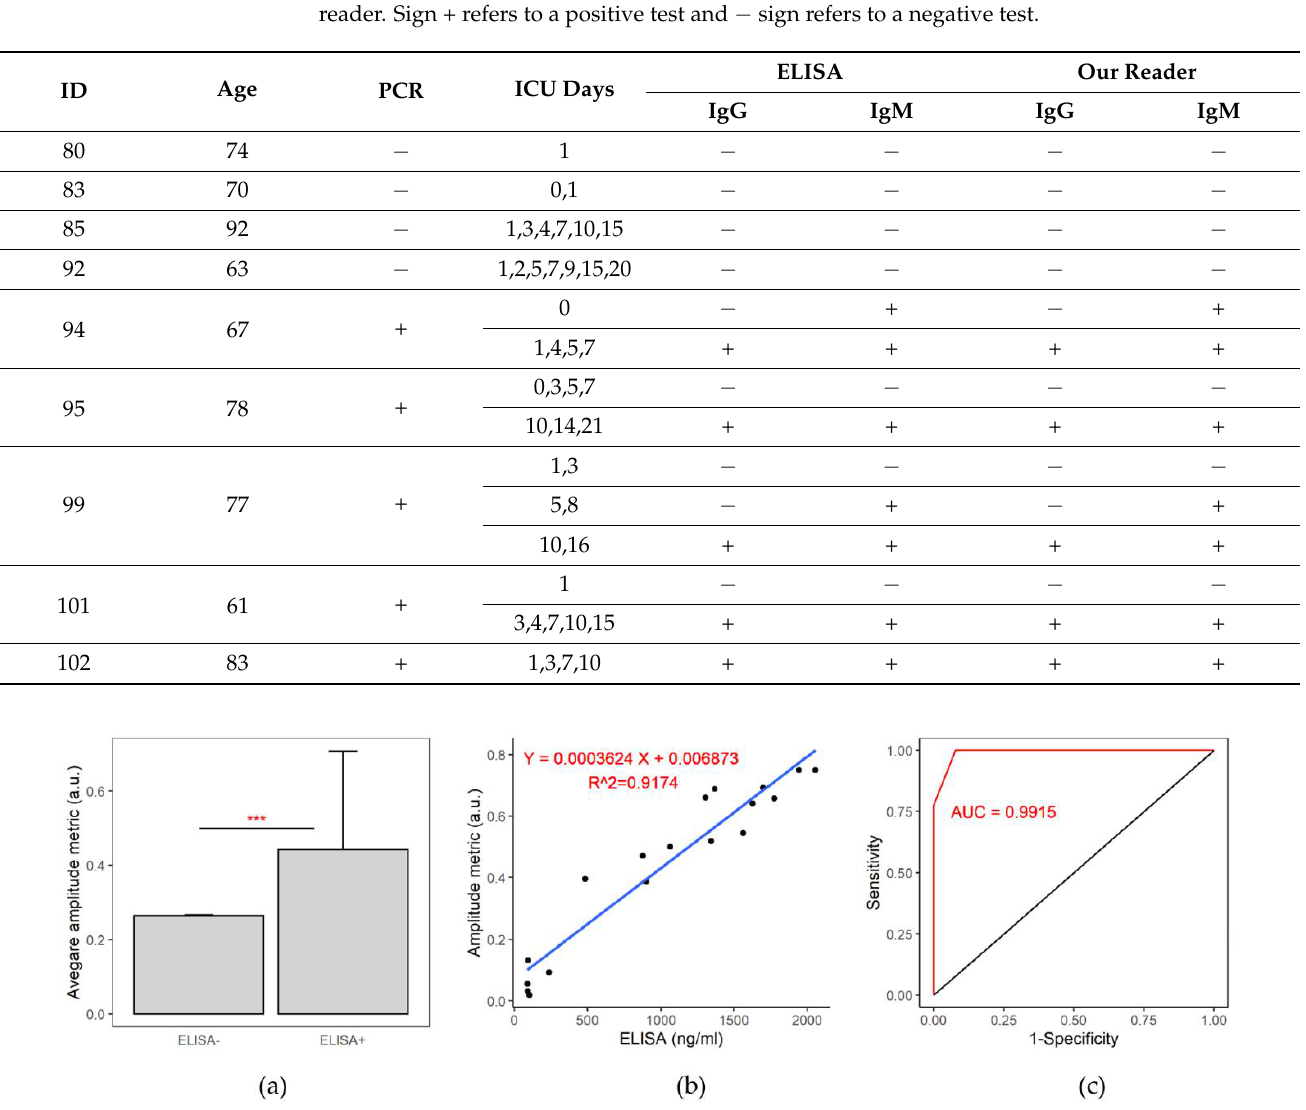
Figure 3. ( a ) A bar diagram showing average IgG amplitude metrics between the ELISA− and ELISA+ samples. The average IgG amplitude metrices is significantly higher in ELISA+ samples (*** indicates p ≤ 0.001). ( b ) A linear regression plot between the IgG amplitude metric and ELISA for IgG. ( c ) A ROC curve that shows the performance of our device for detecting ELISA− and ELISA+ IgG samples.